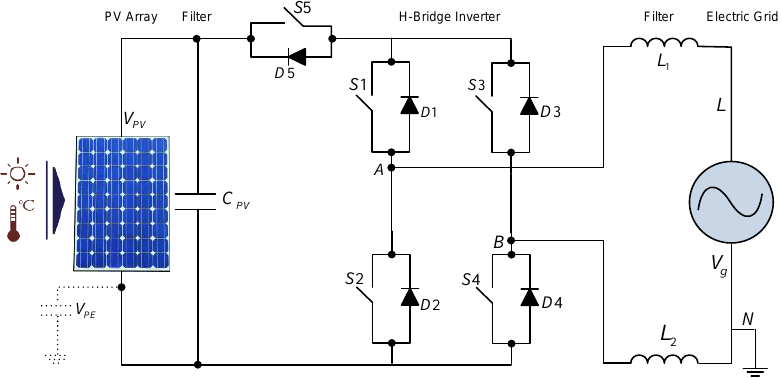
Figure 7. Schematic diagram of H5 (SMA) Inverter [43,56].